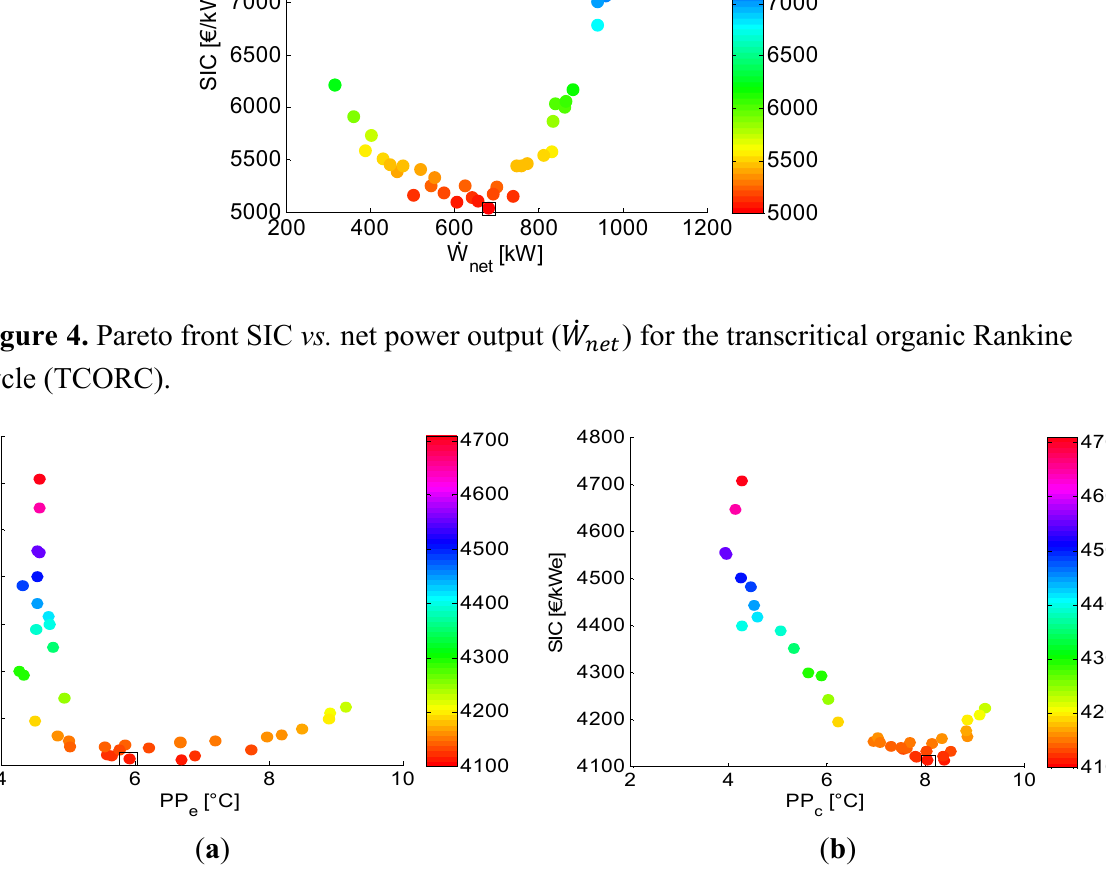
Figure 5. ( a ) Pinch point temperature difference evaporator ( (cid:1842)(cid:1842) temperature difference condenser ( (cid:1842)(cid:1842)